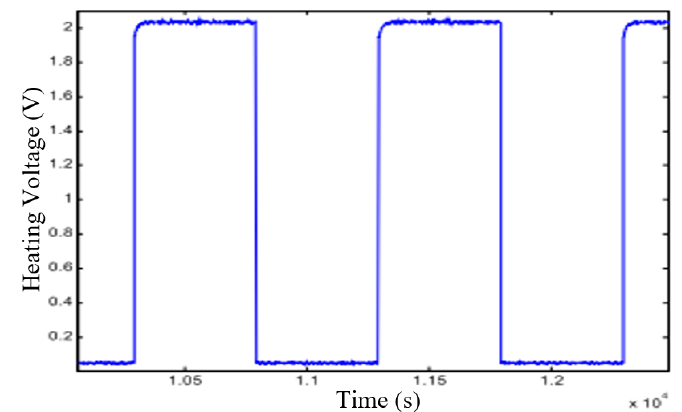
Figure 1. Voltage applied to the heating resistence.